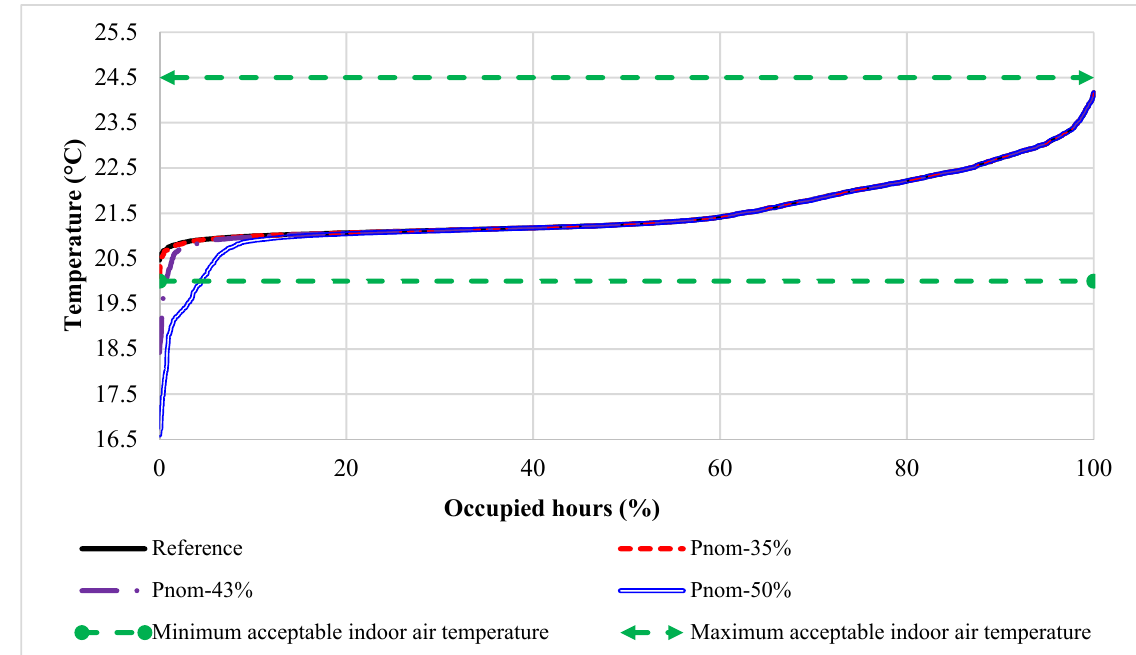
Figure 12. Peak power demand-limiting effect on indoor temperature of the coldest room (namely,